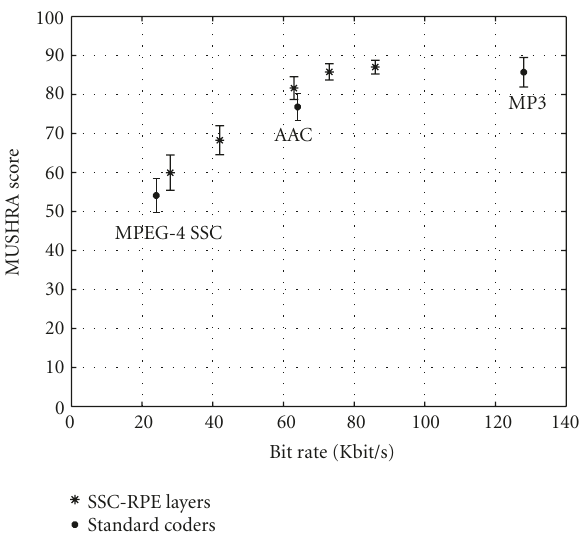
Figure 13: Overall listening test results. These results come from averaging across all excerpts and all subjects. The 7 and 10kHz an- chors (not shown in the graph for the sake of clarity) achieved mean MUSHRA scores of 61 and 74, respectively, whereas the hidden ref- erence (not shown) attained a score of 97.